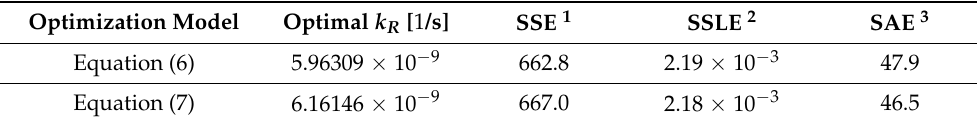
Figure A2. Accuracy percentage gain as the number of spatial segments increase. Error measure comparison of the optimization models (6) and (7): Table A1. Comparison of optimal reaction rate constants. Optimization Model